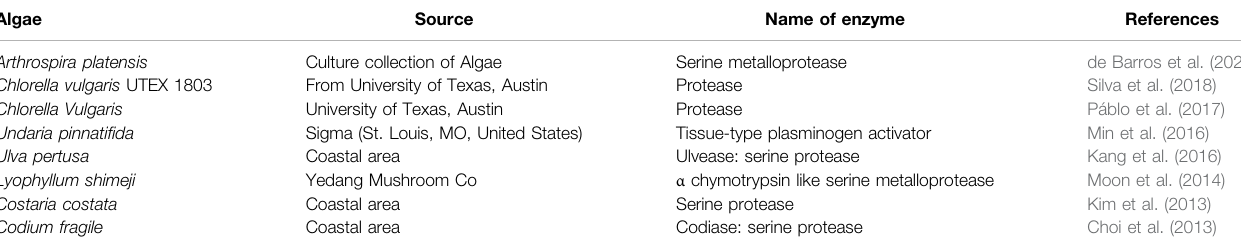
TABLE 2 | Fibrinolytic enzymes produced by algae from different sources. Algae